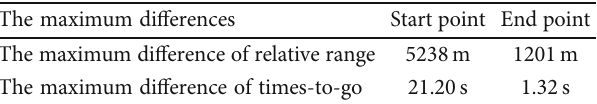
Table 4: Summary of the di ff erences of times-to-go and relative range with delay τ = 0 : 4s